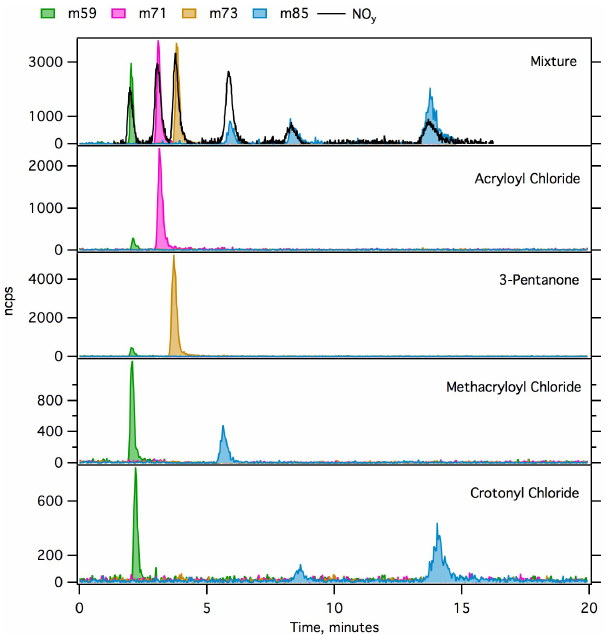
Figure 2. I − CIMS and baseline-corrected NO y measurements are shown for a single GC chromatogram of a calibration mixture con- taining all four precursor compounds (top panel). I − CIMS mea- surements of individual calibration mixtures for each of the precur- sor compounds included in Table 1 (bottom four